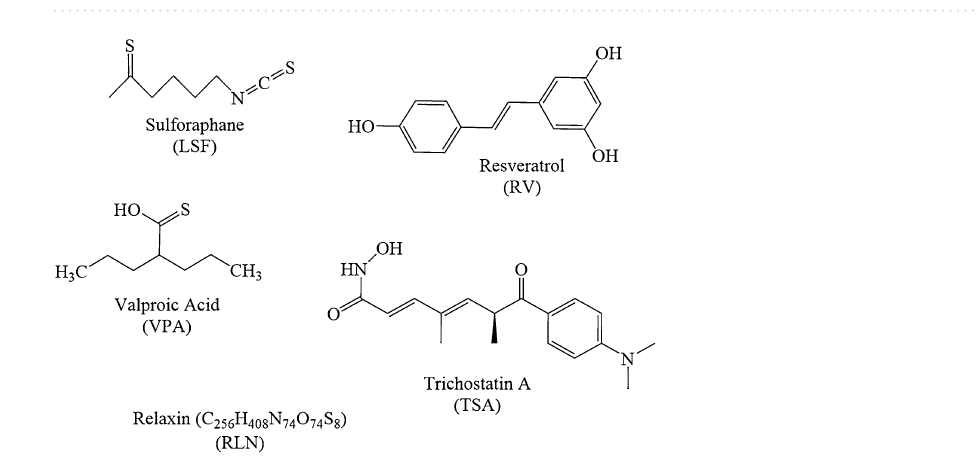
Figure 2. Chemical structure of antioxidant and chromatin modifying